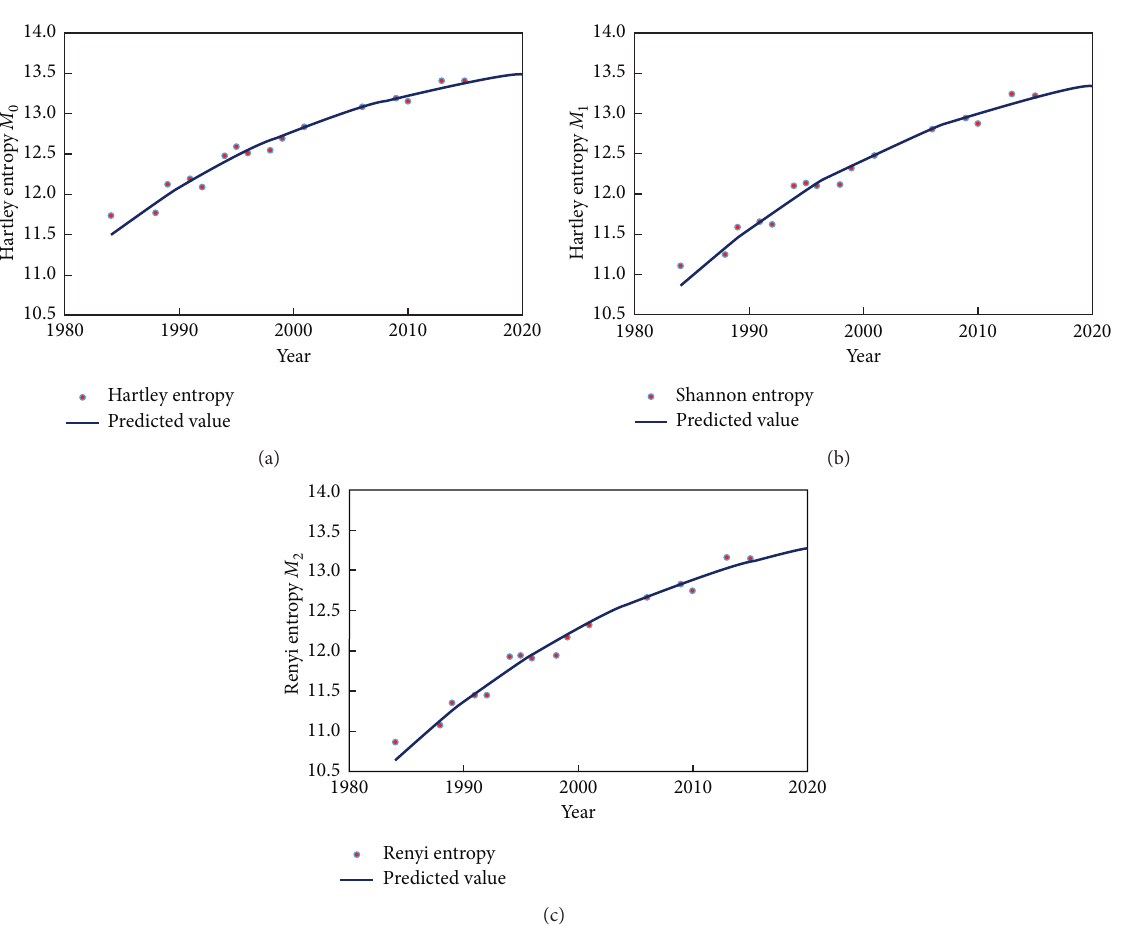
Figure 2: The time series of spatial entropy of Beijing’s urban land-use patterns (1984–2015). (a) Hartley entropy. (b) Shannon entropy. (c) Second-order Renyi entropy. Note: the observed values come between 1984 and 2015. The plots show the predicted values before 2020.